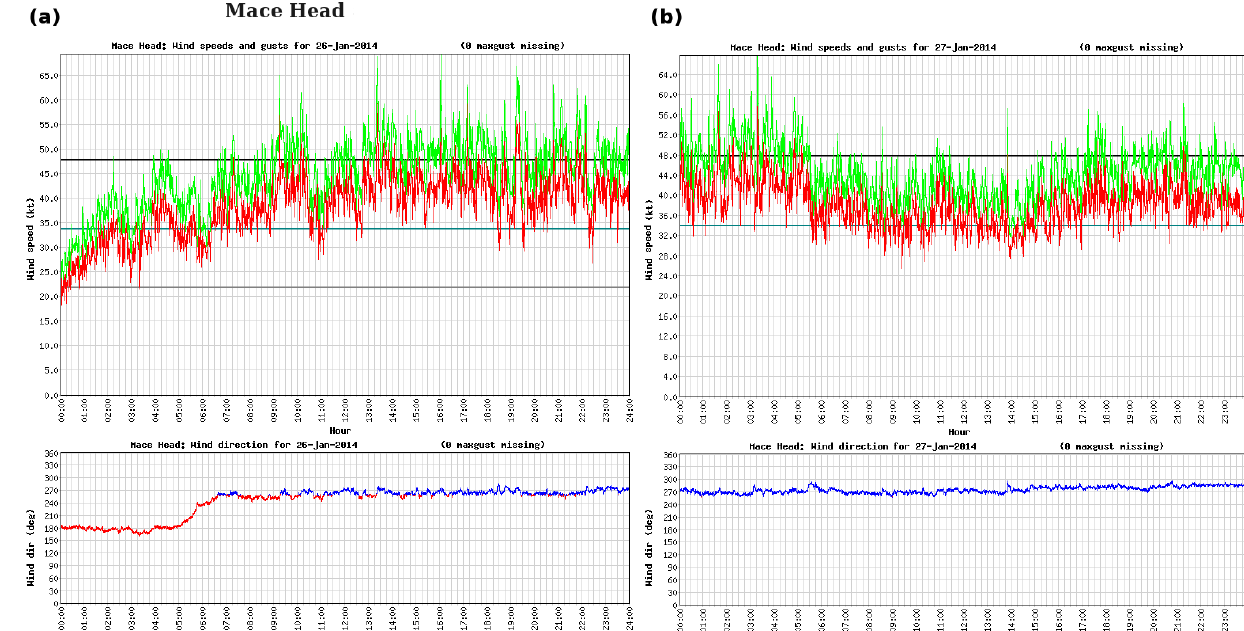
Figure 14. Observations from Met Éireann Synoptic (TUCSON) stations at Mace Head for wind speeds and gusts (top panels) and direction (bottom panels) on (a) 26 January and (b) 27 January 2014. Top panels: Red = wind speed (kt); Green = wind gust (kt). For context, hori- zontal lines show mean speed boundaries on the Beaufort scale. Grey = Force 6 “Strong breeze” (22kt); Turquoise = Force 8 “Gale” (34kt); and Black = Force 10 “Storm” (48kt). Note the different scales for wind speed. Bottom panels: Direction of wind speeds and gusts ( ◦ ).